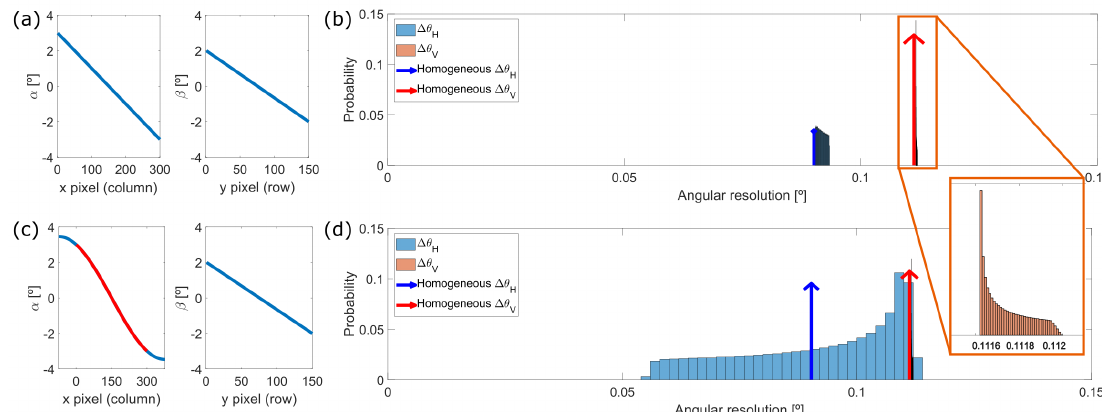
Figure 7. Simulated probability histogram of the angular resolution ( b ) and ( d ) for both scanning directions assuming, respectively, ( a ) linear motion of the MEMS and ( c ) harmonic motion of the MEMS in its fastest direction, being the red curve of α the cropped linear region of the whole motion shown in blue. Homogeneous resolution is calculated with FOV H = 27.5 ◦ and FOV V = 16.5 ◦ .